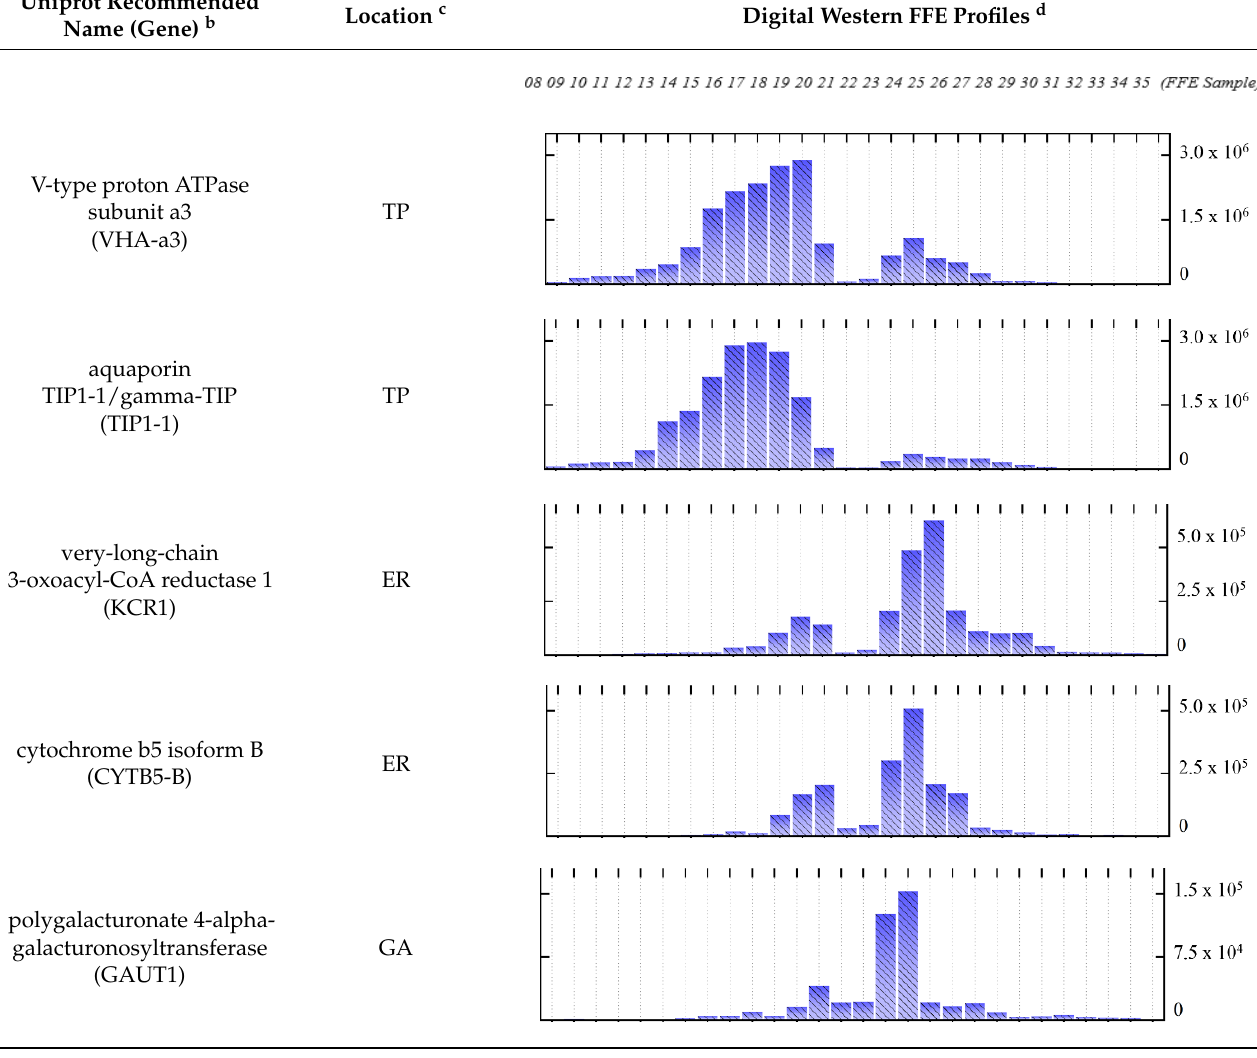
Table 1. Digital western FFE profiles of selected membrane markers from different subcellular compartments a .